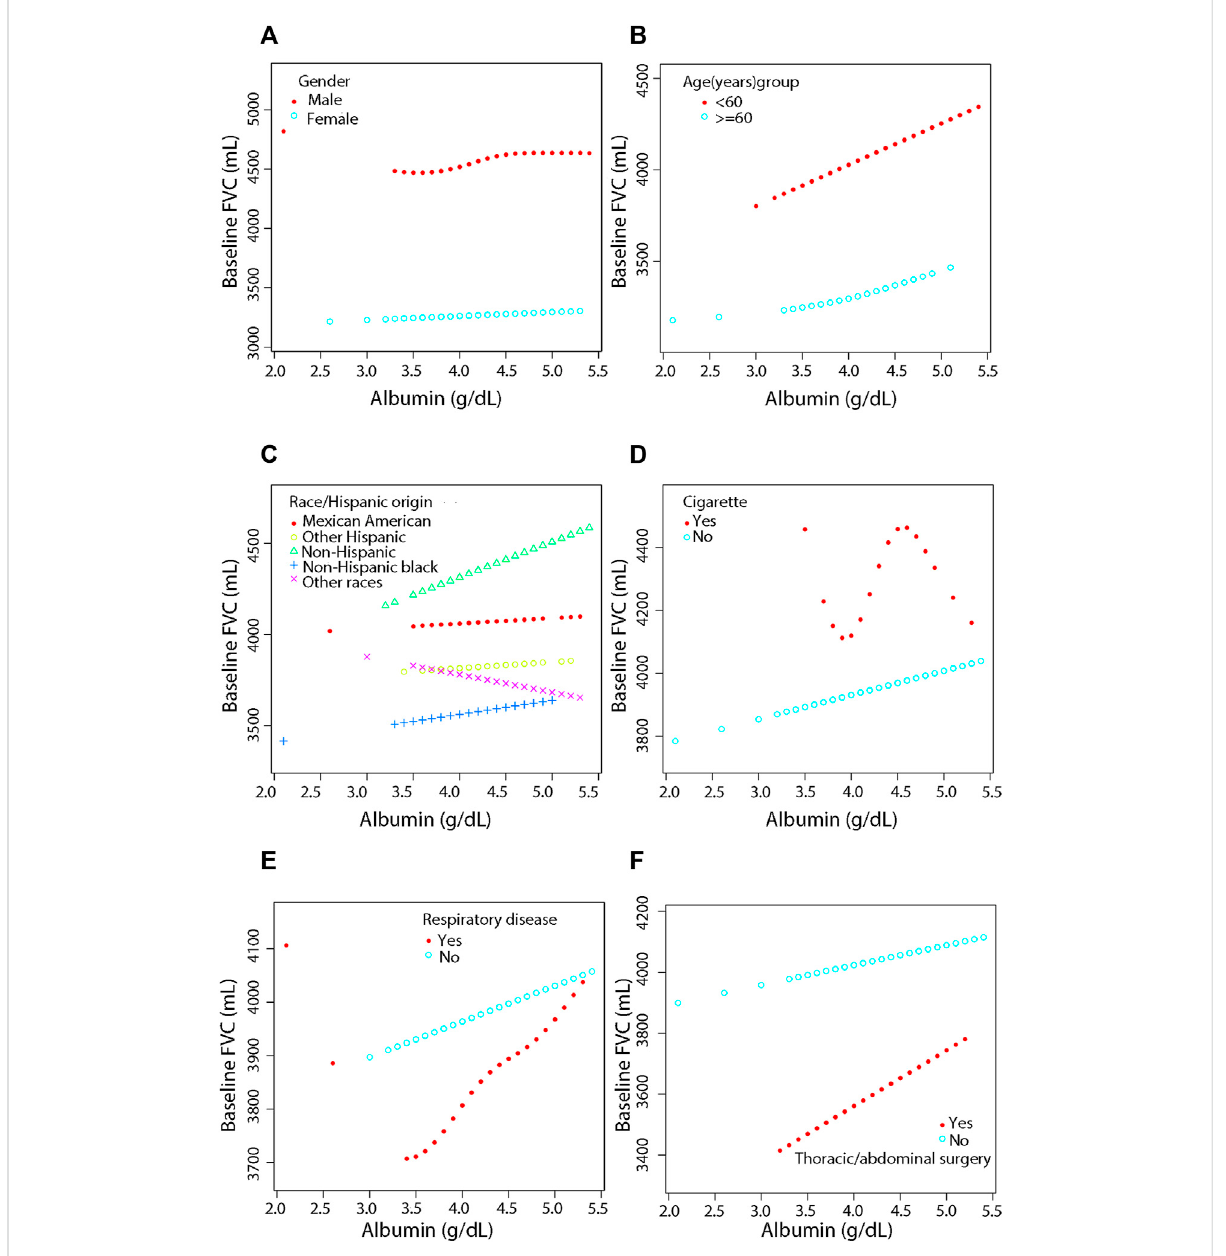
FIGURE 3 Association between serum albumin and Pulmonary Function (FVC) by covariate variables (gender, age, race, cigarette, respiratory disease, surgery). Weighted by: Exam weight in a full sample mobile examination center. Adjusted for globulin (smooth), age (smooth), gender, race, educationlevel,surgery(yes,no),respiratorydisease(yes,no),cigarette(yes,no),weight(smooth),standingheight(smooth),diastolicbloodpressure (smooth), systolic blood pressure (smooth), glucose, serum (smooth), cholesterol (smooth), creatinine (smooth), ALT (smooth), total calcium (smooth),sodium(smooth),potassium(smooth). (A) Strati fi edbygender. (B) Strati fi edbyagedichotomy. (C) Strati fi edrace. (D) Strati fi edbycigarette. (E) Strati fi ed by respiratory disease. (F) Strati fi ed by